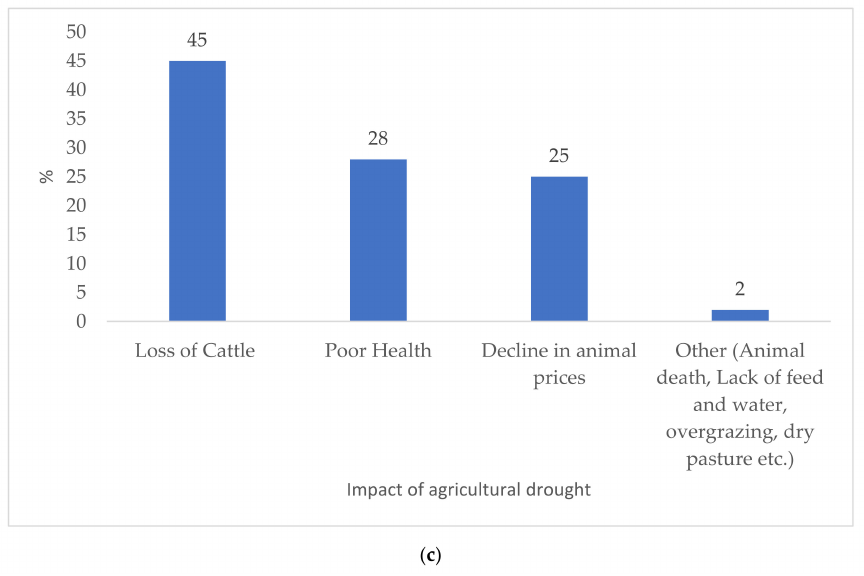
Figure 4. Impact of agricultural drought on livestock: ( a ) goats; ( b ) sheep; and ( c )